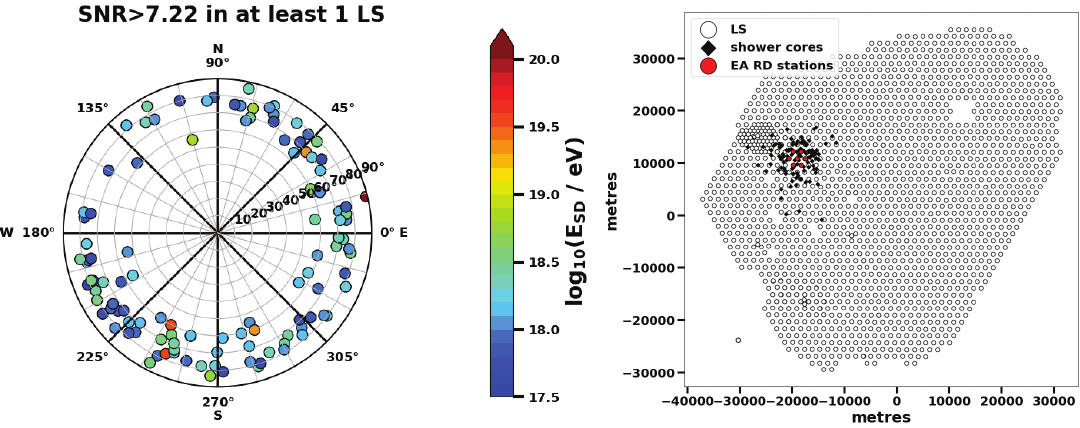
Figure 3. Data taken with the RD engineering array over the course of 12 months. Left: Angular distribution of air showers for which at least one radio pulse with a signal-to-noise ratio (SNR) exceeding a value of 7.22 (defined as the maximum amplitude squared divided by the RMS power in a noise window) was seen in at least one antenna at the expected pulse arrival time after triggering the readout by the WCDs. Right: Distribution of the impact points of the showers for which an air-shower radio signal was